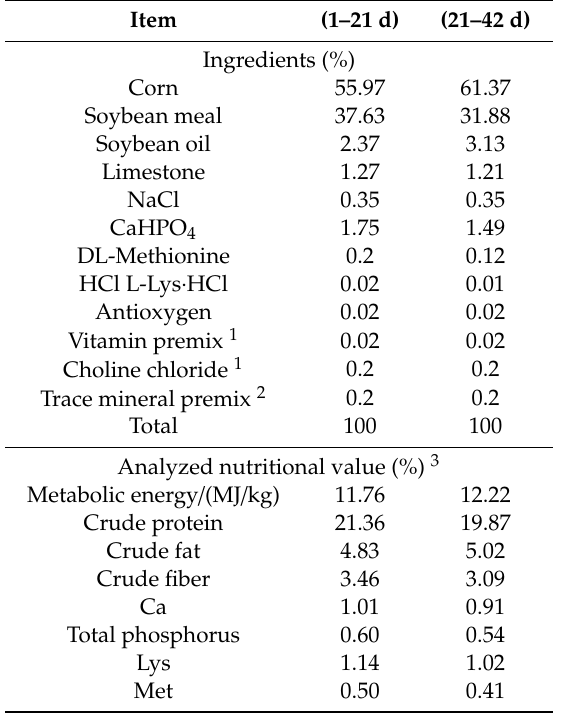
Table 1. Composition of basal diet and nutrient levels (as-fed